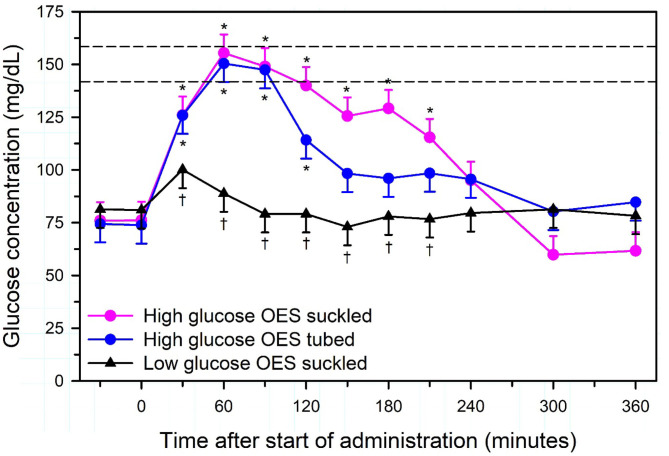
Change in plasma glucose concentration (least squares mean ± standard error) in seven calves that were administered 2 L of a high-glucose oral electrolyte solution (OES; glucose = 405 mmol/L) by suckling or esophageal intubation, or 2 L of a low-glucose OES (glucose = 56 mmol/L) by suckling. The horizontal dashed lines indicate the range of values (140–160 mg/dl) for the renal threshold for glucose in neonatal calves. An asterisk (*) indicates significantly different from the time = 0 min value. A dagger (†) indicates significantly different from the value for the high-glucose OES suckled group at the same time. Reproduced with permission from: Nouri and Constable (102).